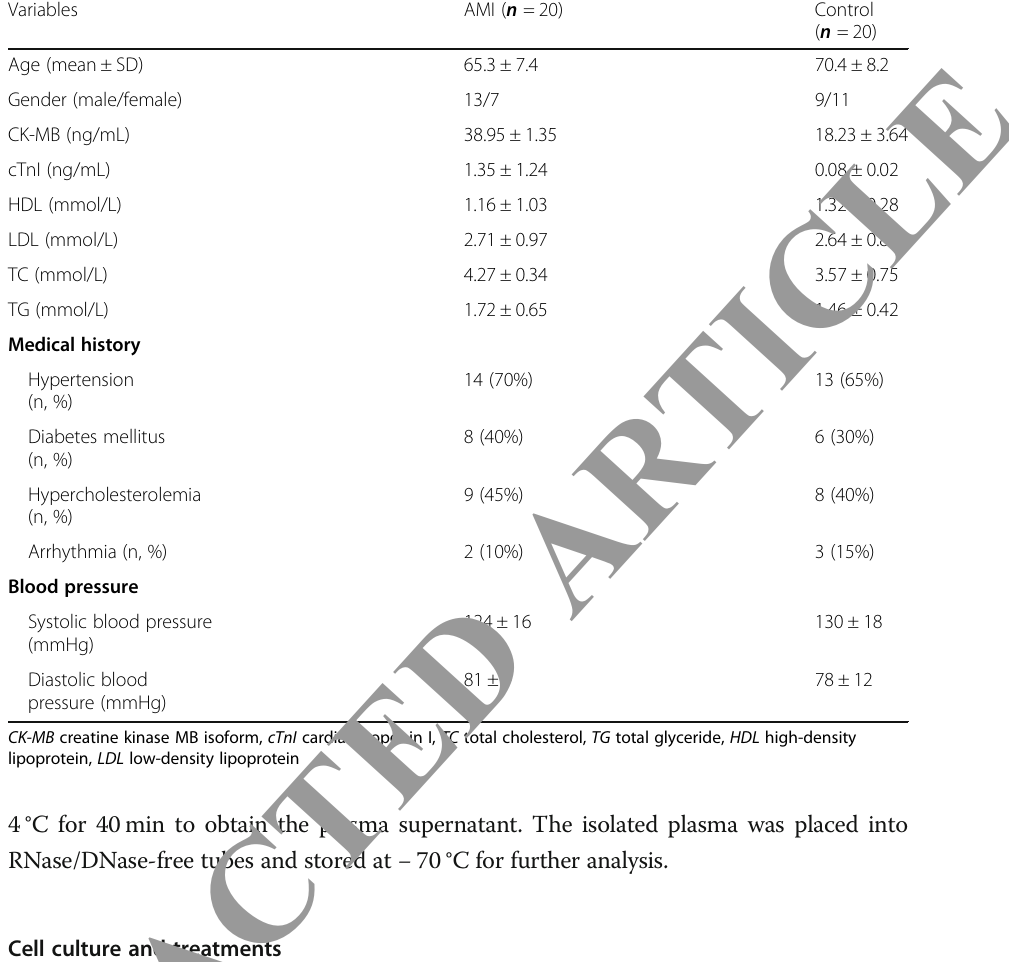
4 °C for 40 min to obtain the plasma supernatant. The isolated plasma was placed into RNase/DNase-free tubes and stored at − 70 °C for further analysis. Cell culture and treatments